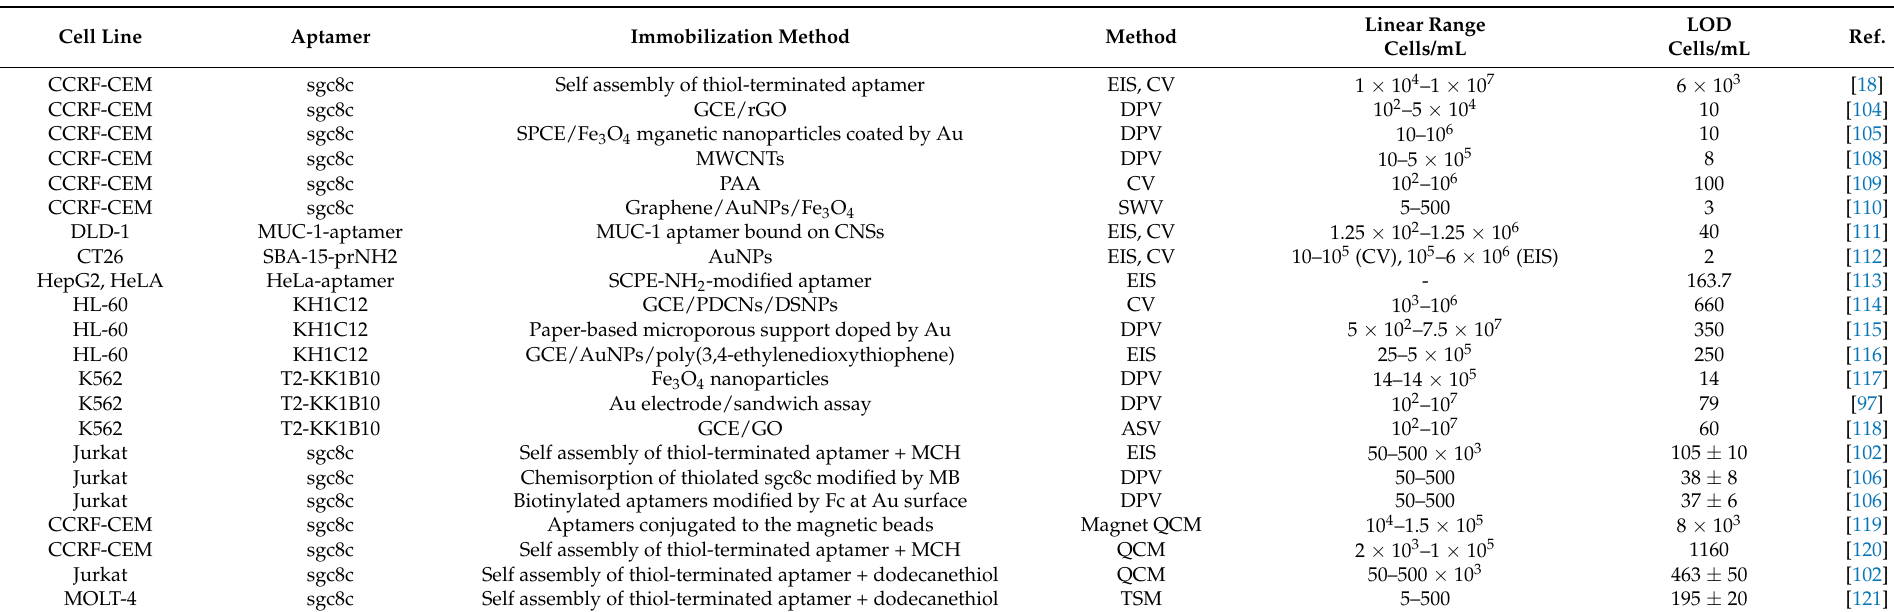
Table 3. Comparison of the properties of electrochemical and acoustic aptasensors for detection cancer